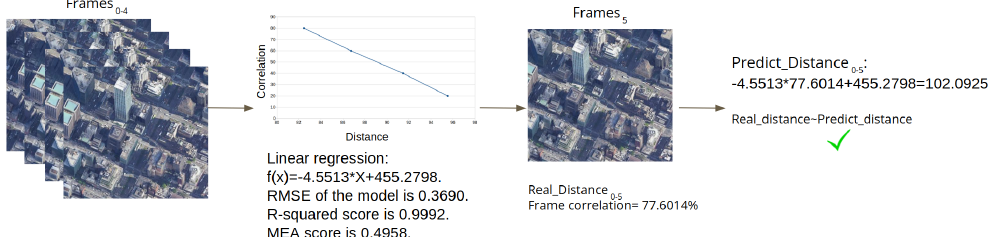
Figure 2. The implementation of the proposed method, using an example in which we obtained five frames ( frame 0 to frame 4 ) and tried to predict the distance for frame 5 ( i = 0, n =